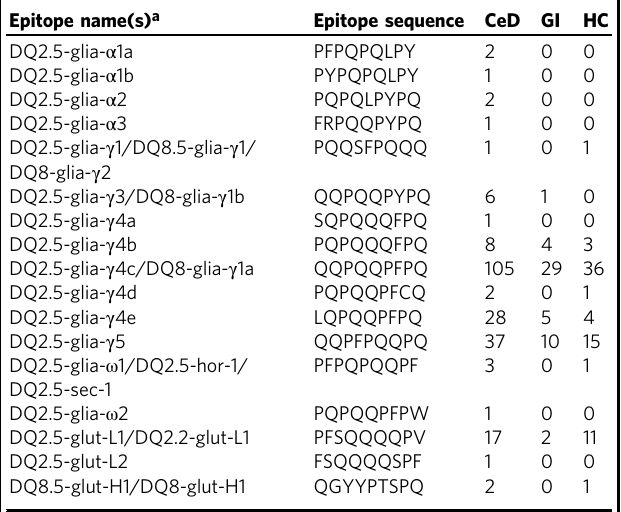
Table 2 Number of detected T-cell epitopes in patients with celiac disease (CeD), non-celiac gastrointestinal disorders (GI), and healthy controls